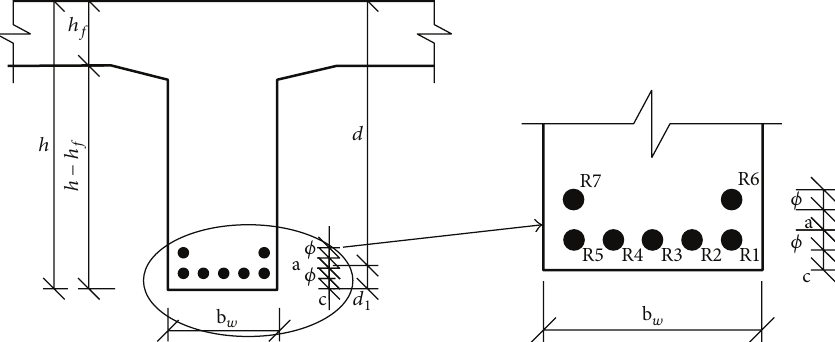
Figure 3: Bridge cross section: identified number of bars after the first diagnostics in 2005.